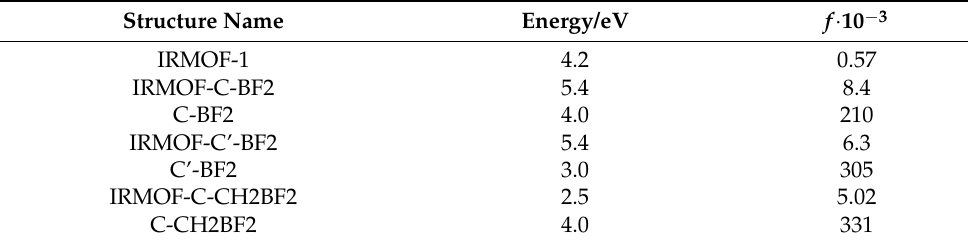
Table 3. Energies and oscillator strengths of the brightest transitions of IRMOF-C-BF 2 and C-BF 2 in the presence of H 2 and CO 2 as probe guest